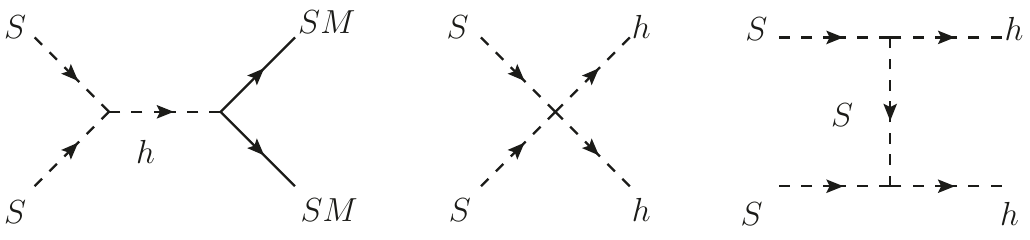
Figure 1 . Singlet-scalar Higgs portal scenario (SHP): annihilation processes of the DM candi- date, S